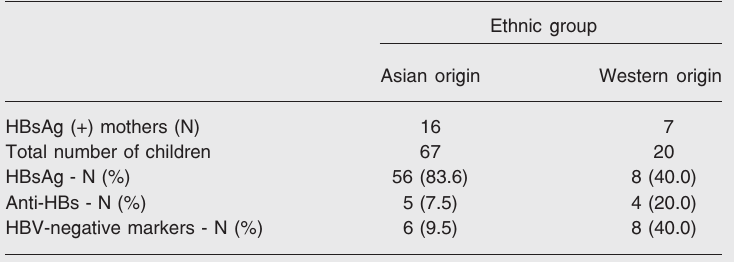
3. Frequency of hepatitis B virus (HBV) markers in the progeny of HBsAg- positive